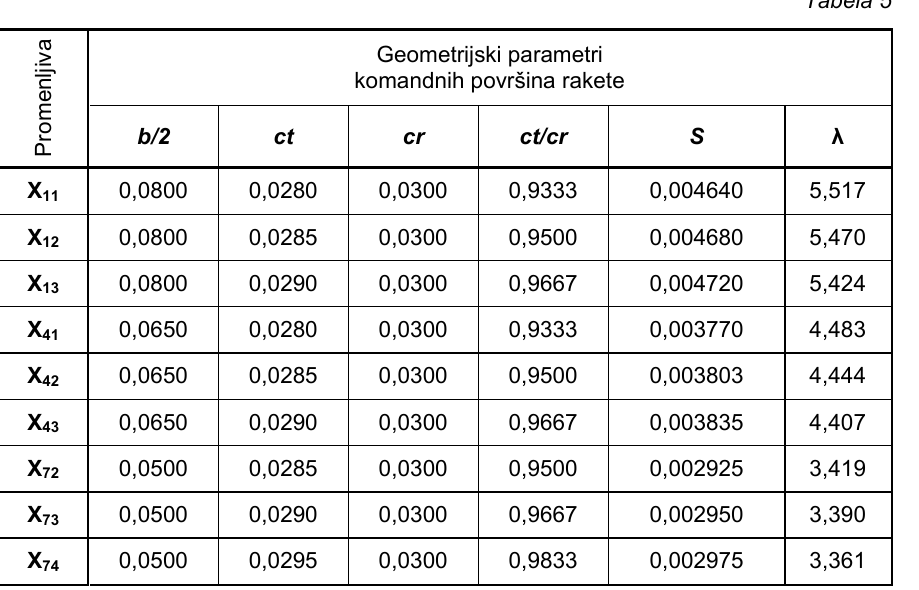
Geometrijski parametri komandnih površina